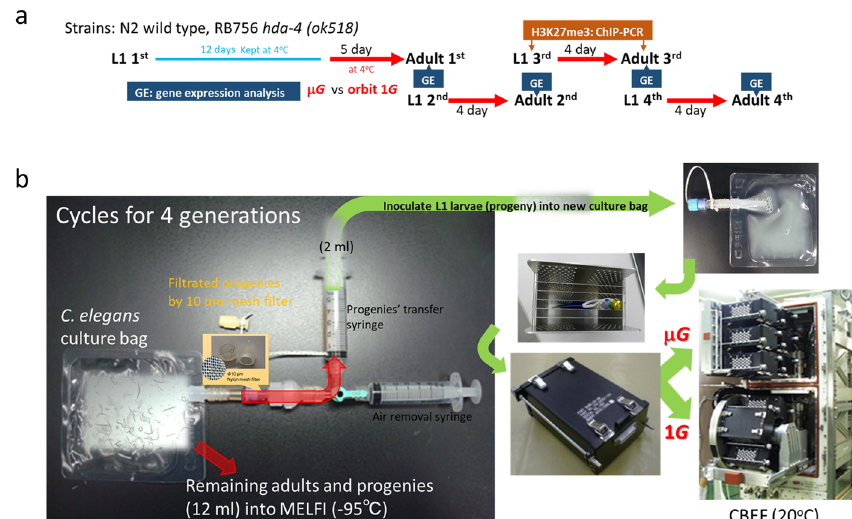
Fig. 1 Schematic diagram and illustration of the space fl ight experiment to assess microgravity impact on epigenetic regulation in C. elegans . a Diagram shows the timeline of the space fl ight experiment “ EPIGENETICS ” . b The start of the experiment was initiated by injecting the L1 larva solution in a syringe into a culture bag and incubating in an upper microgravity box and an arti fi cial 1 G centrifuge box of CBEF (Cell Biology Experiment Facility). After culturing for 5 days (1st generation) and 4 days (2nd to 4th generations), 2 ml of L1 larval progenies were aspirated with a syringe while being fi ltered through a 10 μ m mesh fi lter, and transferred to a new culture bag. The remaining culture bags (adults and L1 progenies mixture) were frozen at − 95 °C in MELFI (Minus Eighty degree Celsius Laboratory